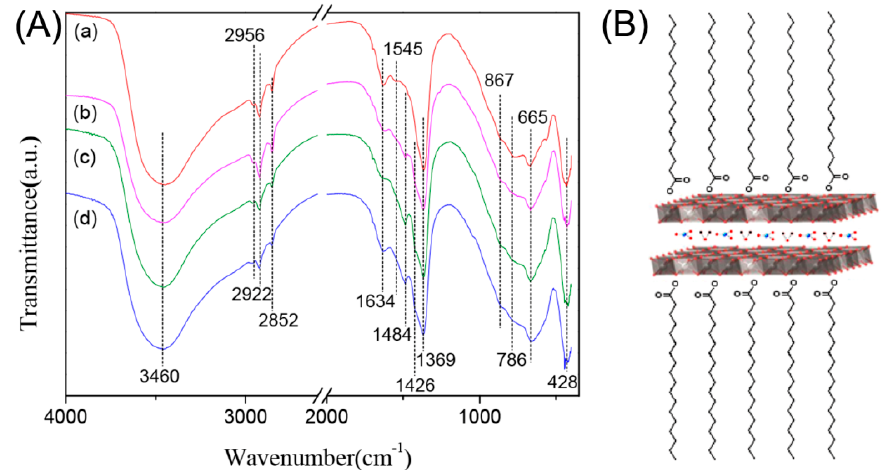
Figure 2. ( A ) FTIR (Fourier transform infrared spectroscopy) spectra of the synthesized LDHs. ( a ) S–NiMgAl–Mn; ( b ) S–NiMgAl–Co; ( c ) S–NiMgAl–Cu and ( d ) S–NiMgAl–Zn; ( B ) Schematic illustration of stearate surface modified LDHs.